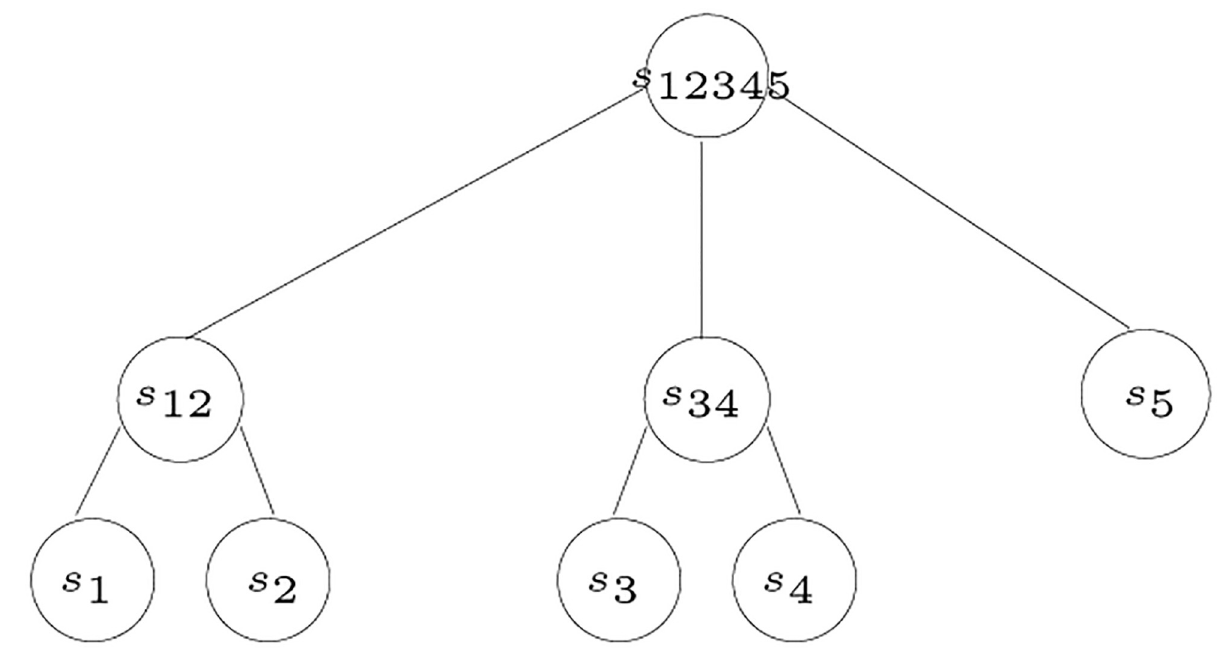
Fig 6. An example of a tree to test compatibility with posets